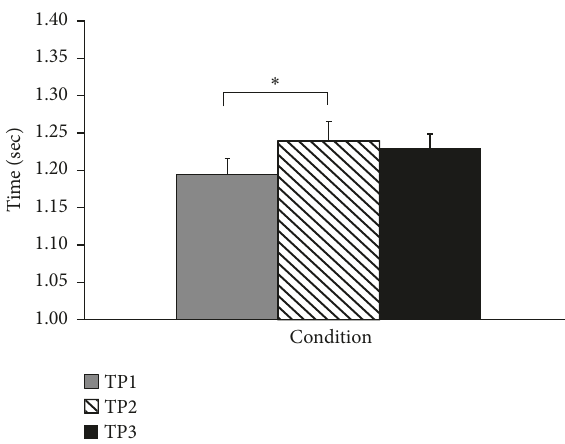
Figure 3: Turning time. Significant difference ( 𝑝 < 0.05 ) is shown with the asterisk. TP1 is turning with no insole. TP2 turning immediately after being provided with the insole and TP3 turning after 6 min of walking with the insole.